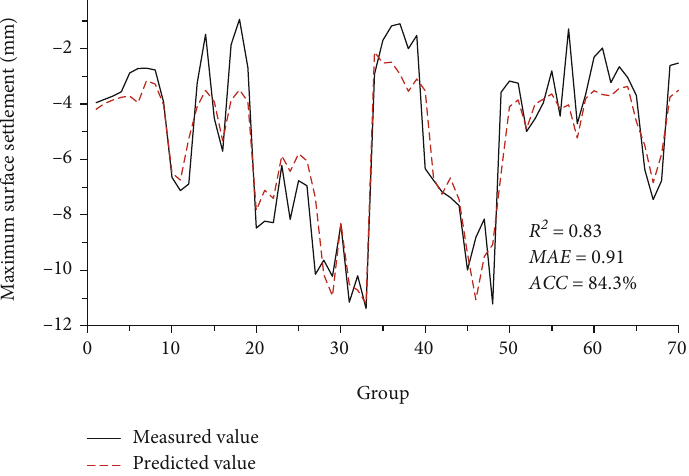
Figure 4: Prediction of optimized model with fi ltered parameters.